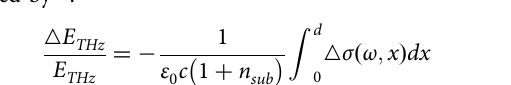
Fig. 3 Photo-induced changes of terahertz photoconductivity in CsFAMA thin fi lms. a The real part and b the imaginary part of the photo-induced change of the terahertz photoconductivity calculated from the time-domain THz spectra recorded at 5 ps delay time for carrier densities varying from 6.9 × 10 17 to 7.5 × 10 18 cm − 3 . The pump wavelength was 550 nm (photon energy ~2.25 eV). All error bars indicate standard errors based on multiple measurements. Dash-dotted lines are fi ts using the Drude – Smith model (DS model), red solid lines are fi ts using the Drude – Debye model (DD model). The fi ts using the Drude – Anderson model (DA model) and Drude – Lorentz model (DL model) are not shown, because they are similar to the DD model fi ts. c Schematic photoconductivity from Lorentzian resonance and Anderson localization. Although Anderson localization substantially reduces the dc photoconductivity, carrier hopping can overcome the Anderson localization, resulting in a photoconductivity response similar to the Lorentzian resonance. Inset: Scheme of carrier localization caused by polaron ( E p ) formation and due to the presence of an energy barrier ( E h calculated by 58 :